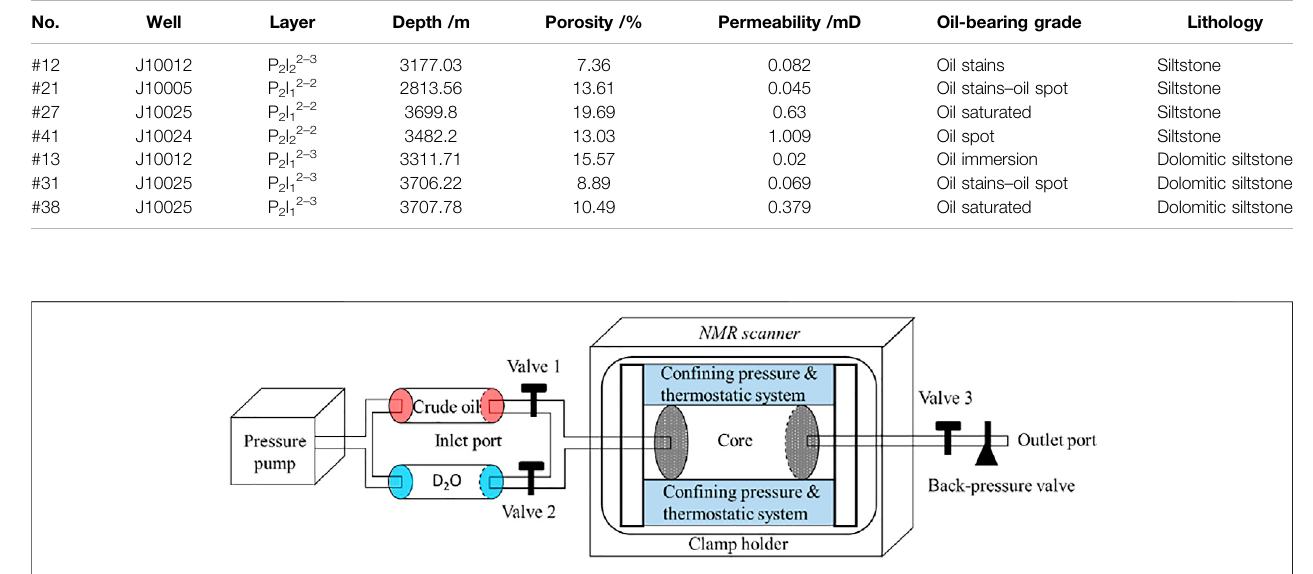
FIGURE 1 | Diagrammatic representation of the experimental